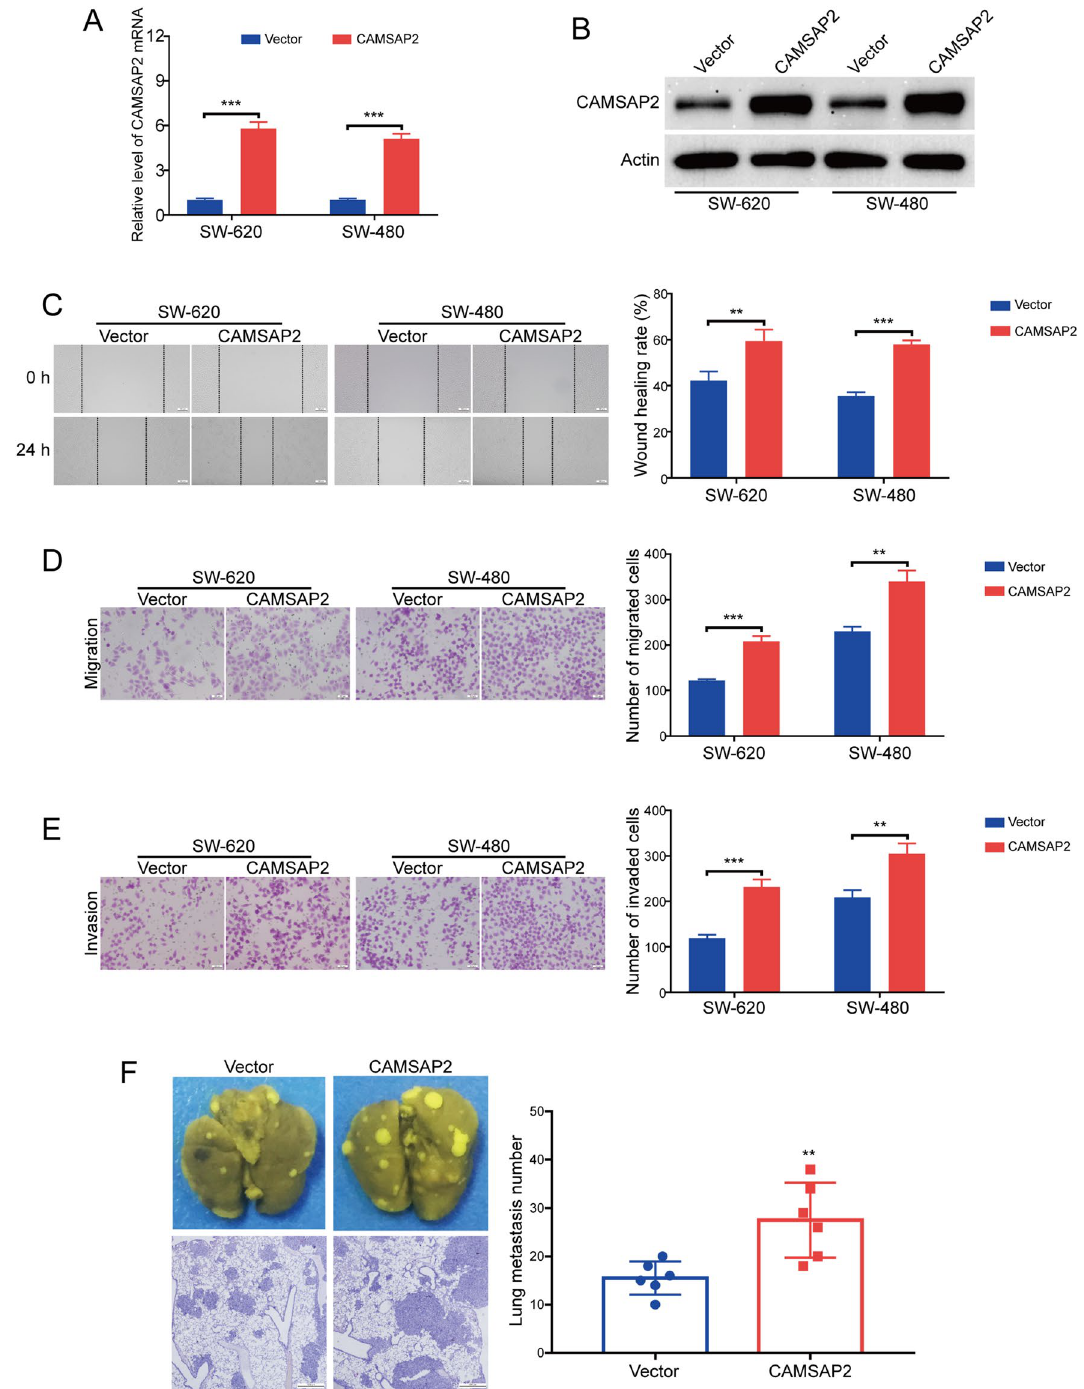
Figure 2. Overexpression of CAMSAP2 promoted migration and invasion in colorectal cancer cells. ( A ) qRT-PCR analysis of CAMSAP2 mRNA in SW-620 and SW-480 cells transduced with CAMSAP2 plasmid (CAMSAP2) or control plasmid (Vector). ( B ) Immunoblotting analysis validated that CAMSAP2 was overexpressed in SW-620 and SW-480 cells transduced with CAMSAP2 plasmid. ( C ) Wound healing assay showed overexpression of CAMSAP2 enhanced cell migration in colorectal cancer cells. Left: representative images of wound scratch. Right: histograms represent the analysis of the wound healing rate. Scale bar: 100 μm. ( D ) Overexpression of CAMSAP2 promoted the migration of colorectal cancer cells examined by transwell migration assay. Scale bar: 100 μm. ( E ) Transwell invasion assay showed that overexpression of CAMSAP2 promoted the invasion in SW-620 and SW-480 cells. Scale bar: 100 μm. (F) Enforced overexpression of CAMSAP2 promoted the lung metastasis in colorectal cancer. Scale bar: 500 μm. ** P < 0.01; *** P <